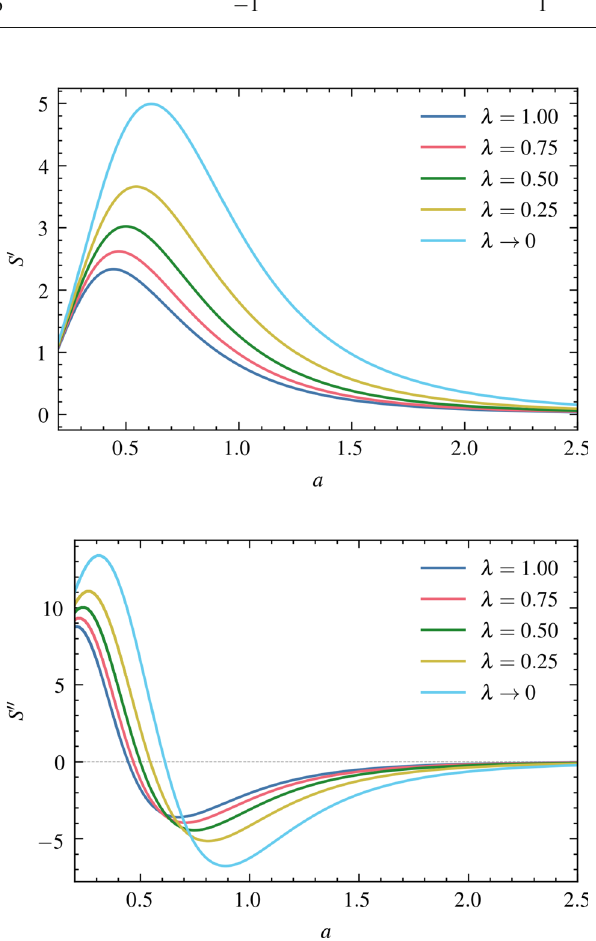
Fig. 13 First ( S (cid:15) ) and second ( S (cid:15)(cid:15) ) derivatives of horizon entropy with respect to scale factor as a function of a for different values of λ (with (cid:12) = 0 . 315 and H = 67 . 4 km/s/Mpc [78]). Here, λ → 0 implies m 0 0 (cid:2) CDM behaviour (in natural